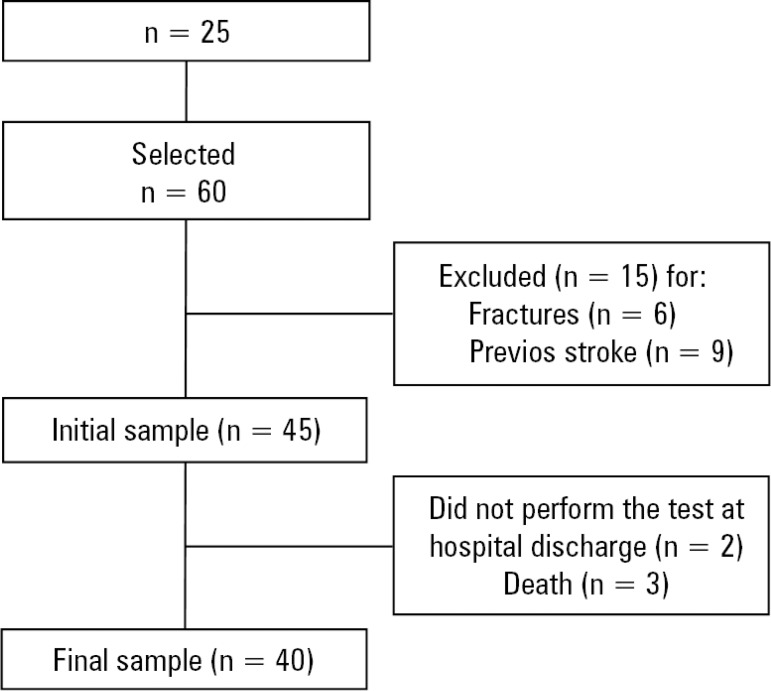
Flowchart representing the individuals who participated in the study and those lost to follow-up.